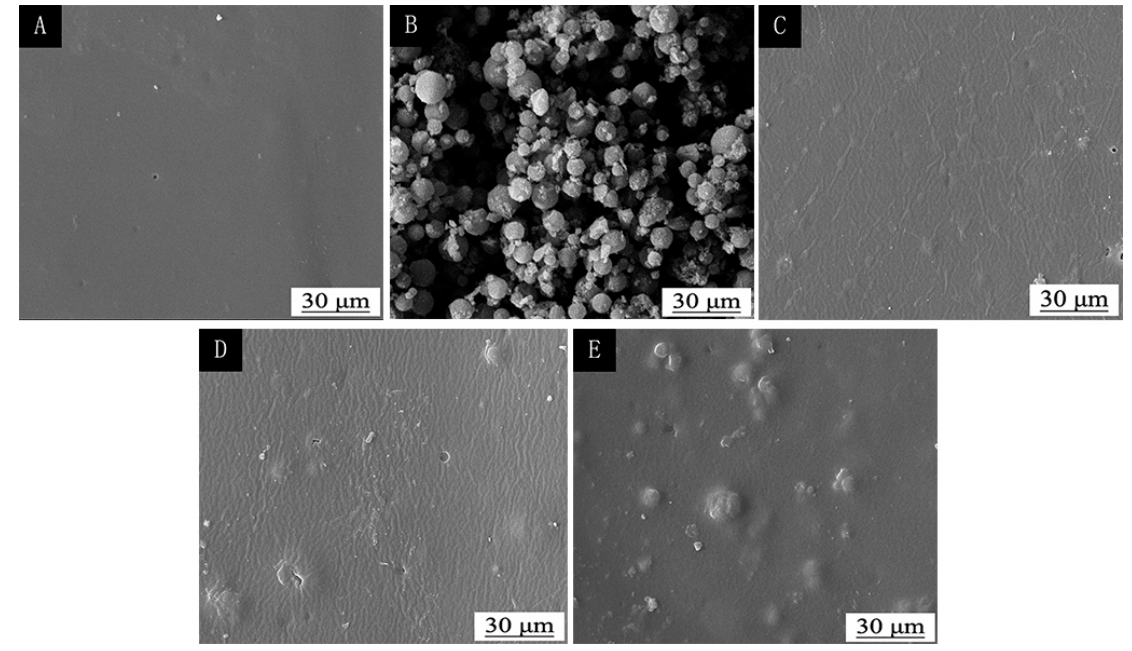
Figure 6. SEM image of ( A ) pure finish film and ( B ) thermochromic microcapsules. The finish film with different thermochromic ink concentration: ( C ) 5.0%, ( D ) 15.0%, and ( E ) 30.0%.